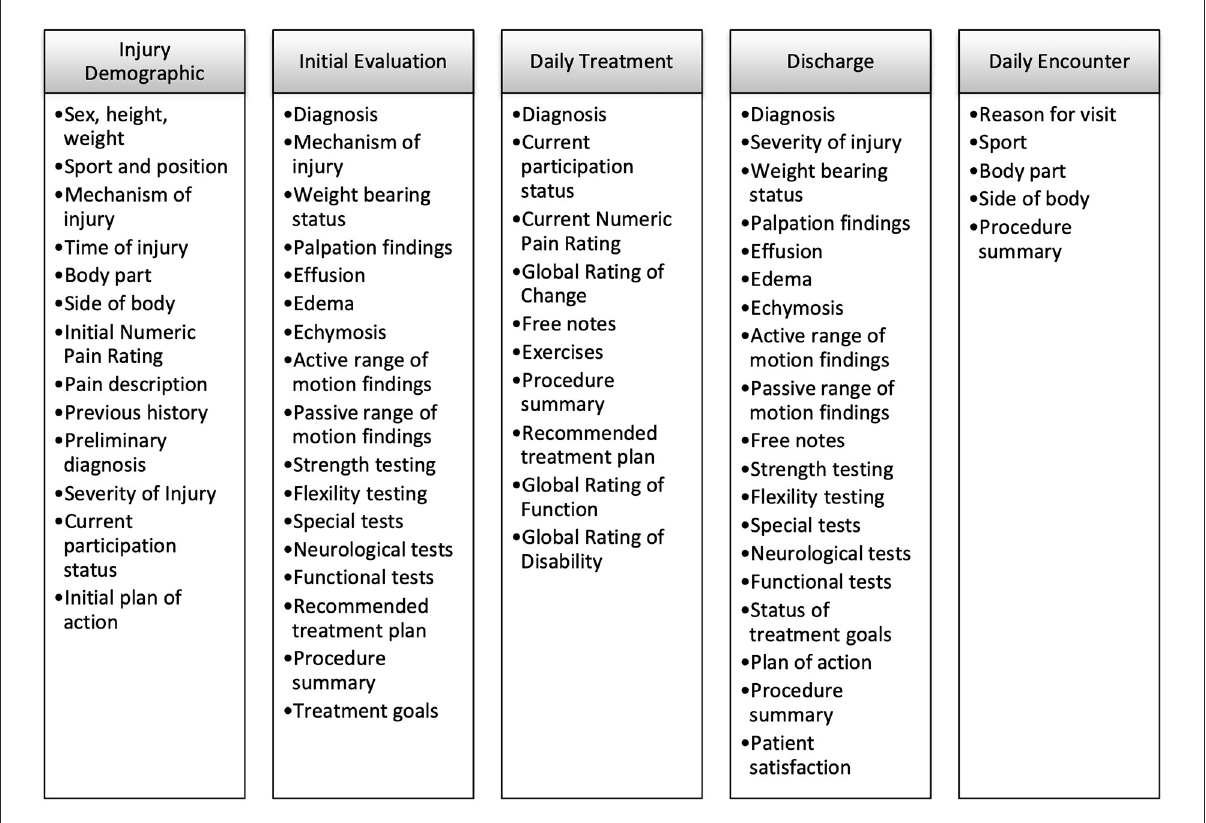
FIGURE1 Primary forms within the electronic medical record with associated